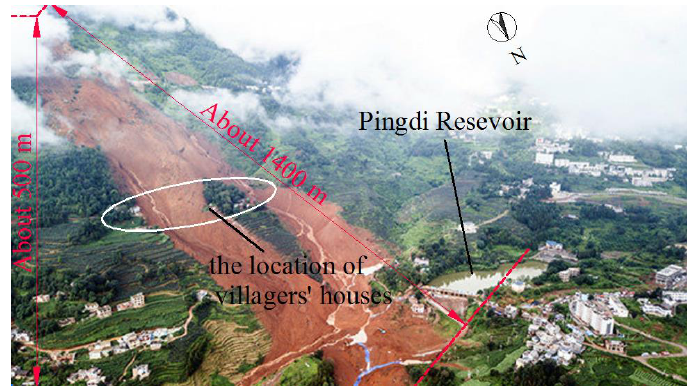
Figure 3. Overview of the landslide (Source: http://baijiahao.baidu.com/s?id=1639927165371855884).